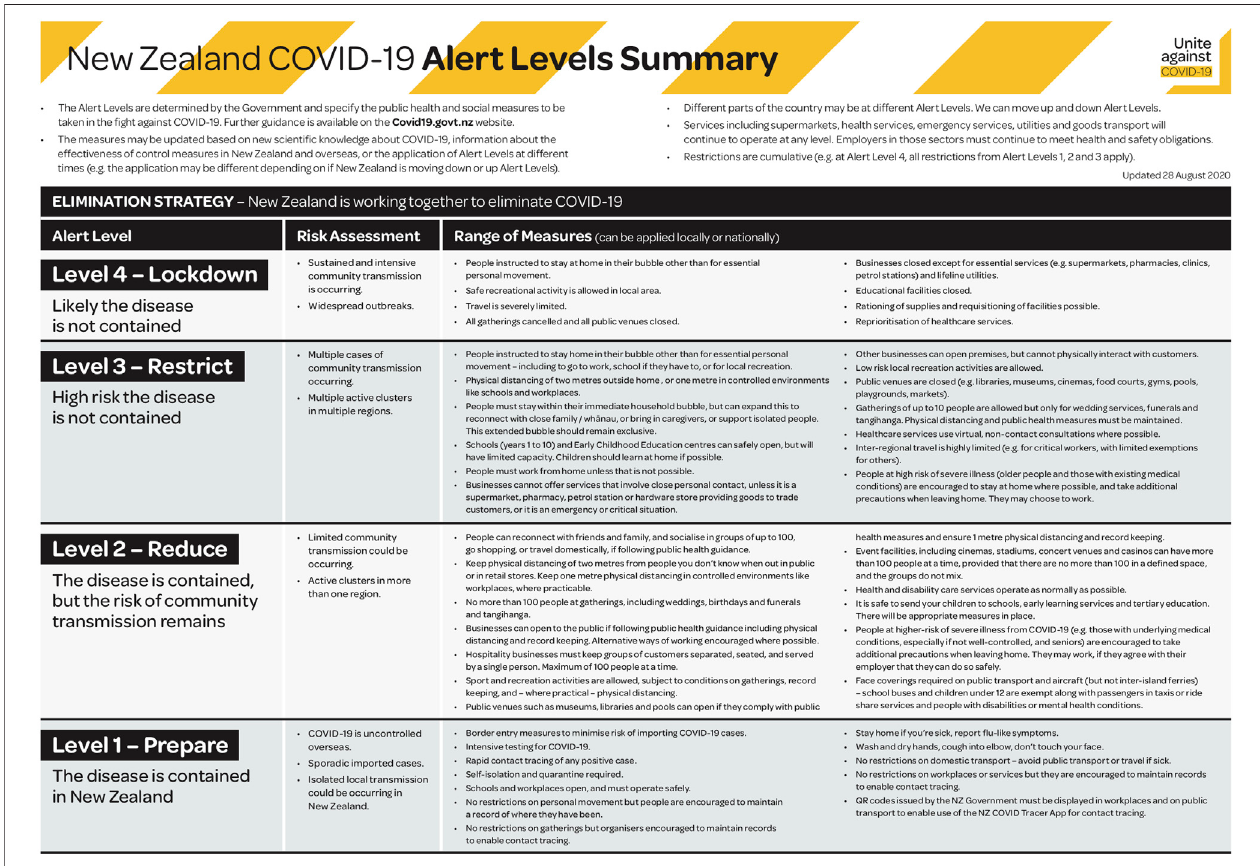
FIGURE 1 | New Zealand COVID-19 alert levels summary. Source. New Zealand Government (2020).